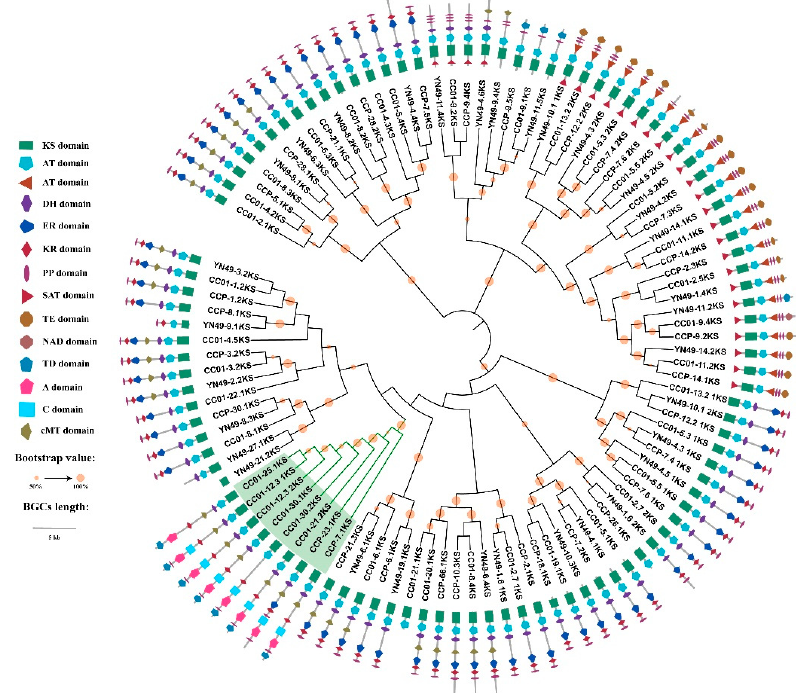
Figure 7. Phylogenetic and structure domain analyses of PKSs and PKS/NRPSs from C. cassiicola YN49, CC01 and CCP based on KS domain sequences. The PKS and PKS/NRPS domains were determined based on antiSMASH analysis. The ML tree was generated using MEGA 6 with the WAG model. Bootstrap support greater than 50% is shown on the branches. KS domain sequences used in this analysis are listed in Supplementary Materials File S5.